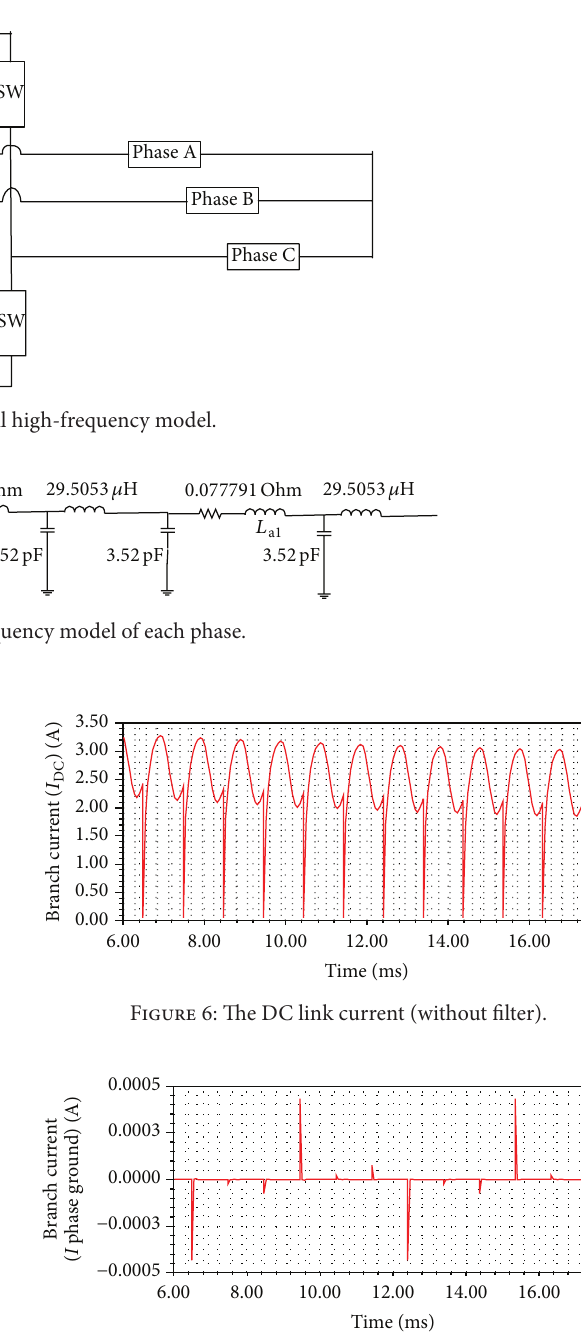
Figure 7: The leakage current (without